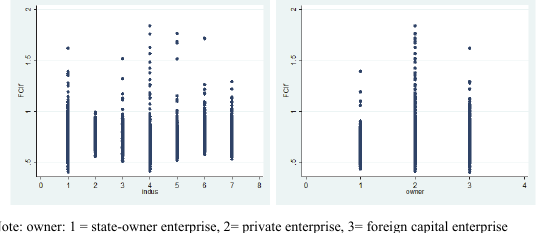
Fig. 2. FCIf by Industry and Ownership Fig. 3. Relationship between FCIf and labor productivity (labpro) and growth of labor productivity (NSLD)